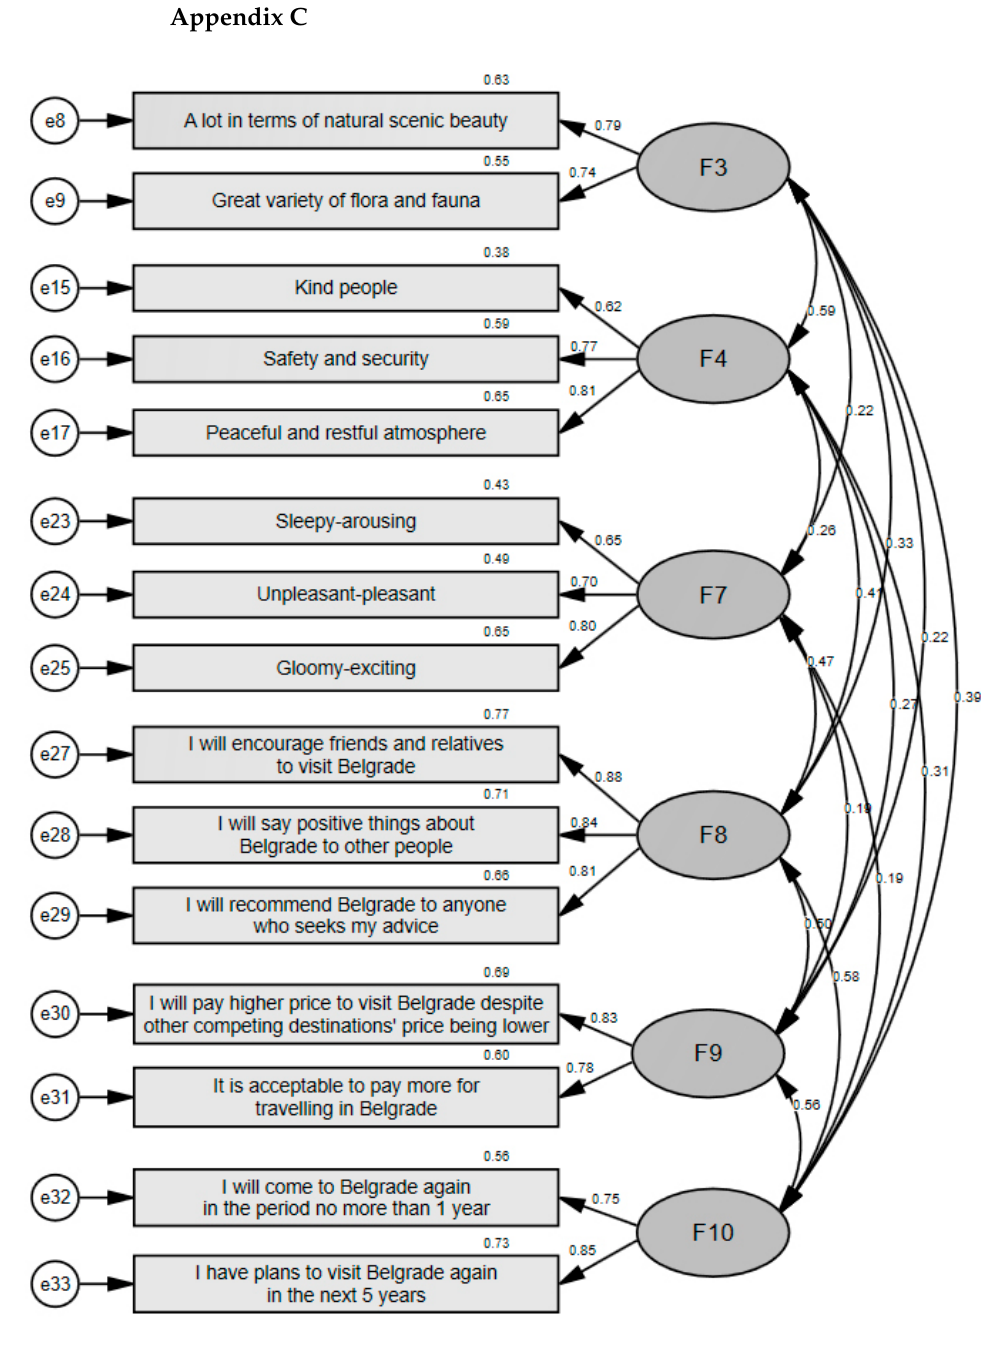
Figure A1. CFA for tourist destination image (e8–e33—error terms for observed variables; F3— Natural environment, F4—Tourist environment, F7—Affective components, F8—Word of mouth and recommendations, F9—Value for money, and F10—Revisits).